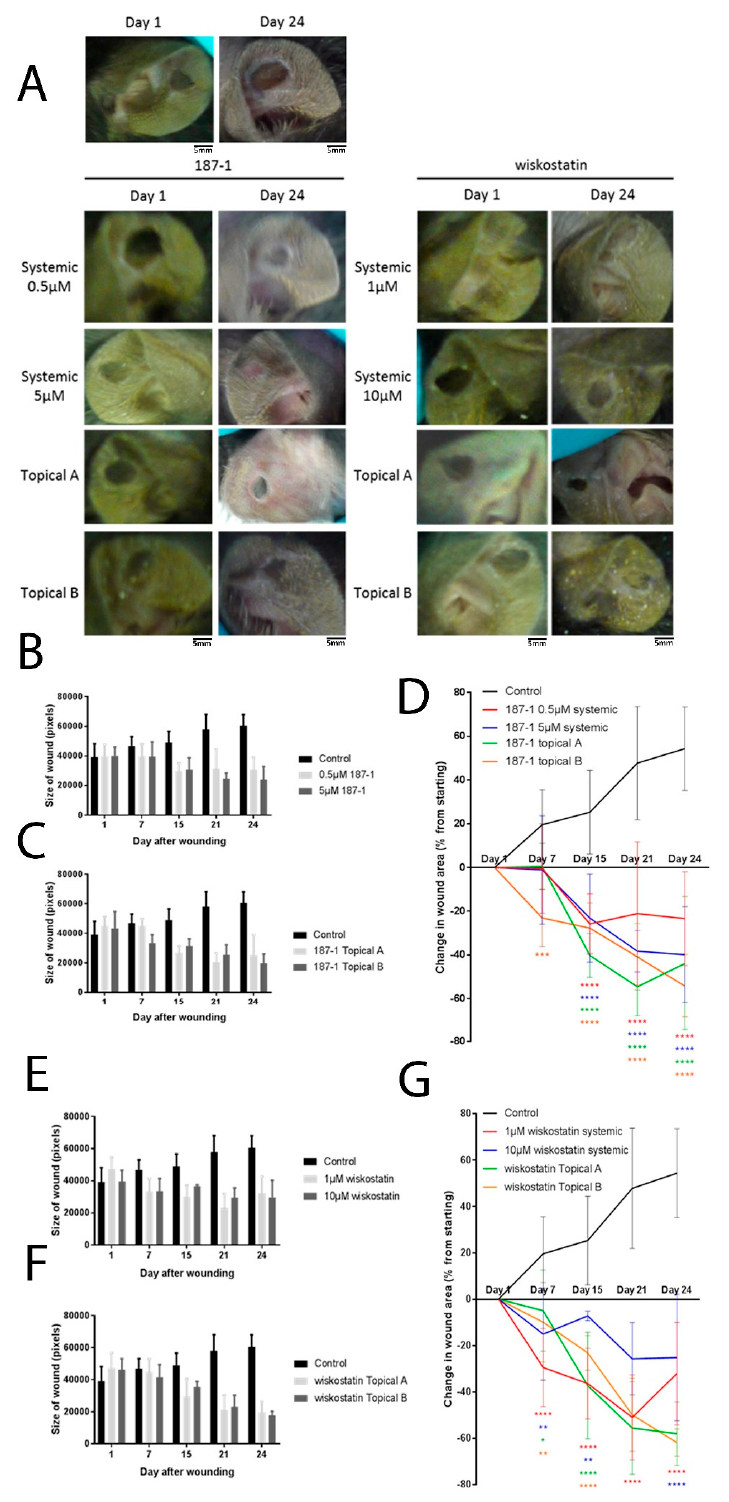
Figure 5. nWASP inhibition and the change in healing rates in a murine mouse model. The effect on the size of the hole punch wound in pixels (mean +/ − SD, n = 6) following the systemic ( A ) and topical ( B ) application of 187-1. Percentage changes in wound area from the first measurement after wounding (day 1) ( C ). The effect of the administration of wiskostatin is shown in ( D – G ). * indicates statistical significance (* p < 0.05, ** p < 0.01, *** p < 0.001 **** p < 0.0001).